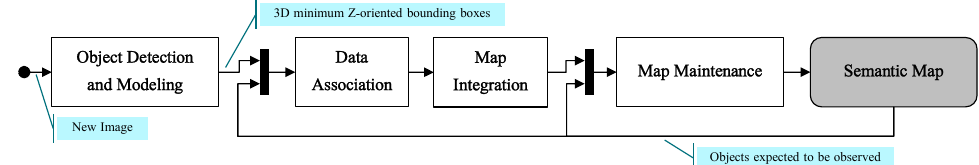
Figure 2. Pipeline of LTC-Mapping . White boxes represent data processing stages while gray box stands for the formal representation of the semantic map, which contains the prior